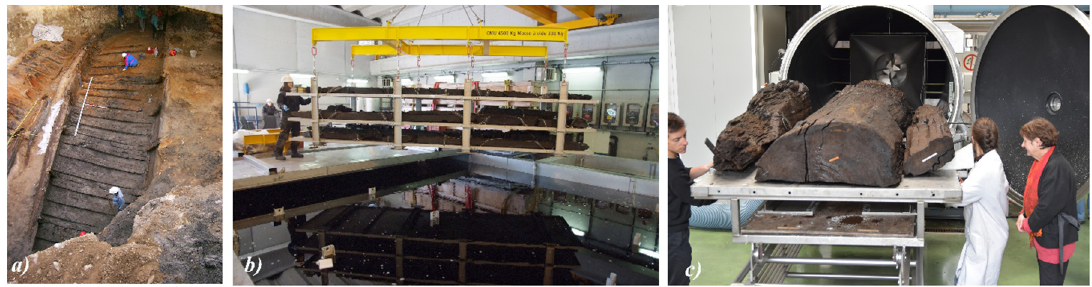
Figure 1. ( a ) Excavation site in Lyon; ( b ) the large pools containing the polyethylene glycol (PEG) where the wreck is immersed to prevent the structure from collapsing and cracking during wood drying; ( c ) drying process carried out inside the apparatus for large-scale lyophilization procedure.